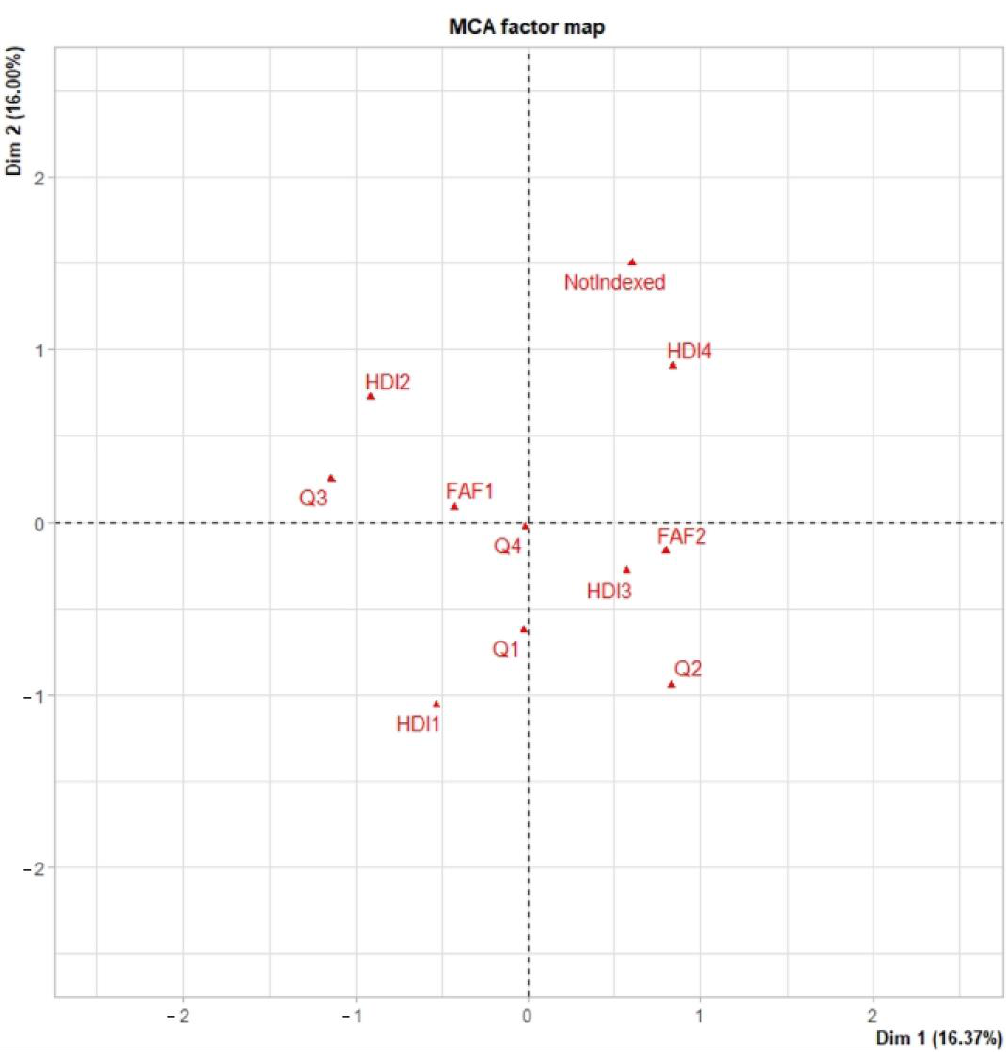
Figure 3. Multiple correspondence analysis for Gestational Diabetes Mellitus prevalence studies. The categories represented on the figures are the following: For the variable FAF: FAF1 represents that the first author is female, FAF2 represents a first author male; for the variable HDI: HDI1 is a very high HDI, HDI2 is a high HDI, HDI3 is medium HDI and HDI4 is a low HID; for the variable JIF: Q1 is a first quartile journal, Q2 is a second quartile journal, Q3 is a third quartile journal, Q4 is a fourth quartile journal, Not indexed is a not indexed journal.